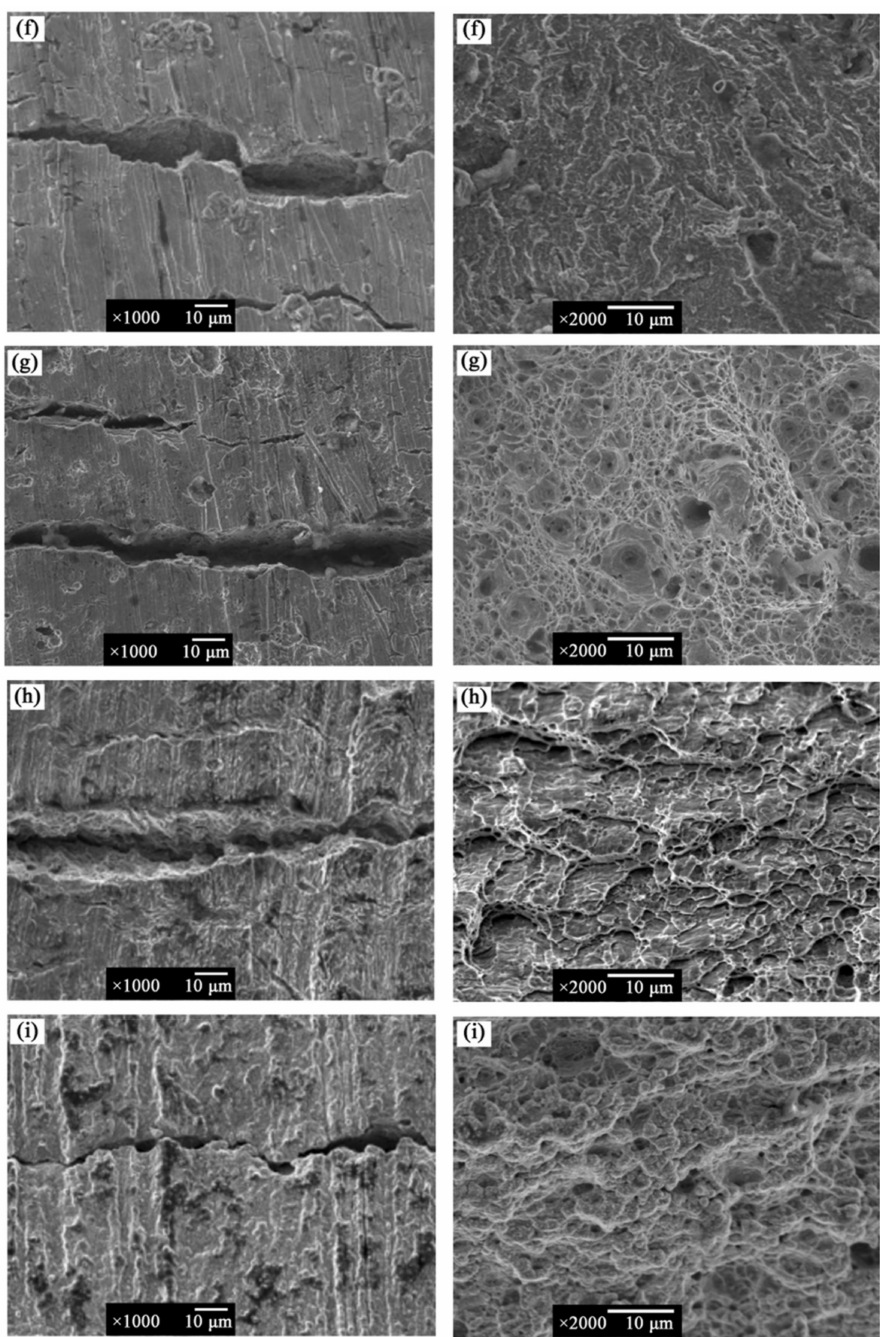
Figure 4. SEM images of X80 steel fracture surface under different conditions in high-pH solution: ( a ) in air; ( b ) without SRB at OCP; ( c ) with SRB at OCP; ( d ) without SRB at − 850 mV; ( e ) with SRB at − 850 mV; ( f ) without SRB at − 1000 mV; ( g ) with SRB at − 1000 mV; ( h ) without SRB at − 1200 mV; ( i ) with SRB at − 1200